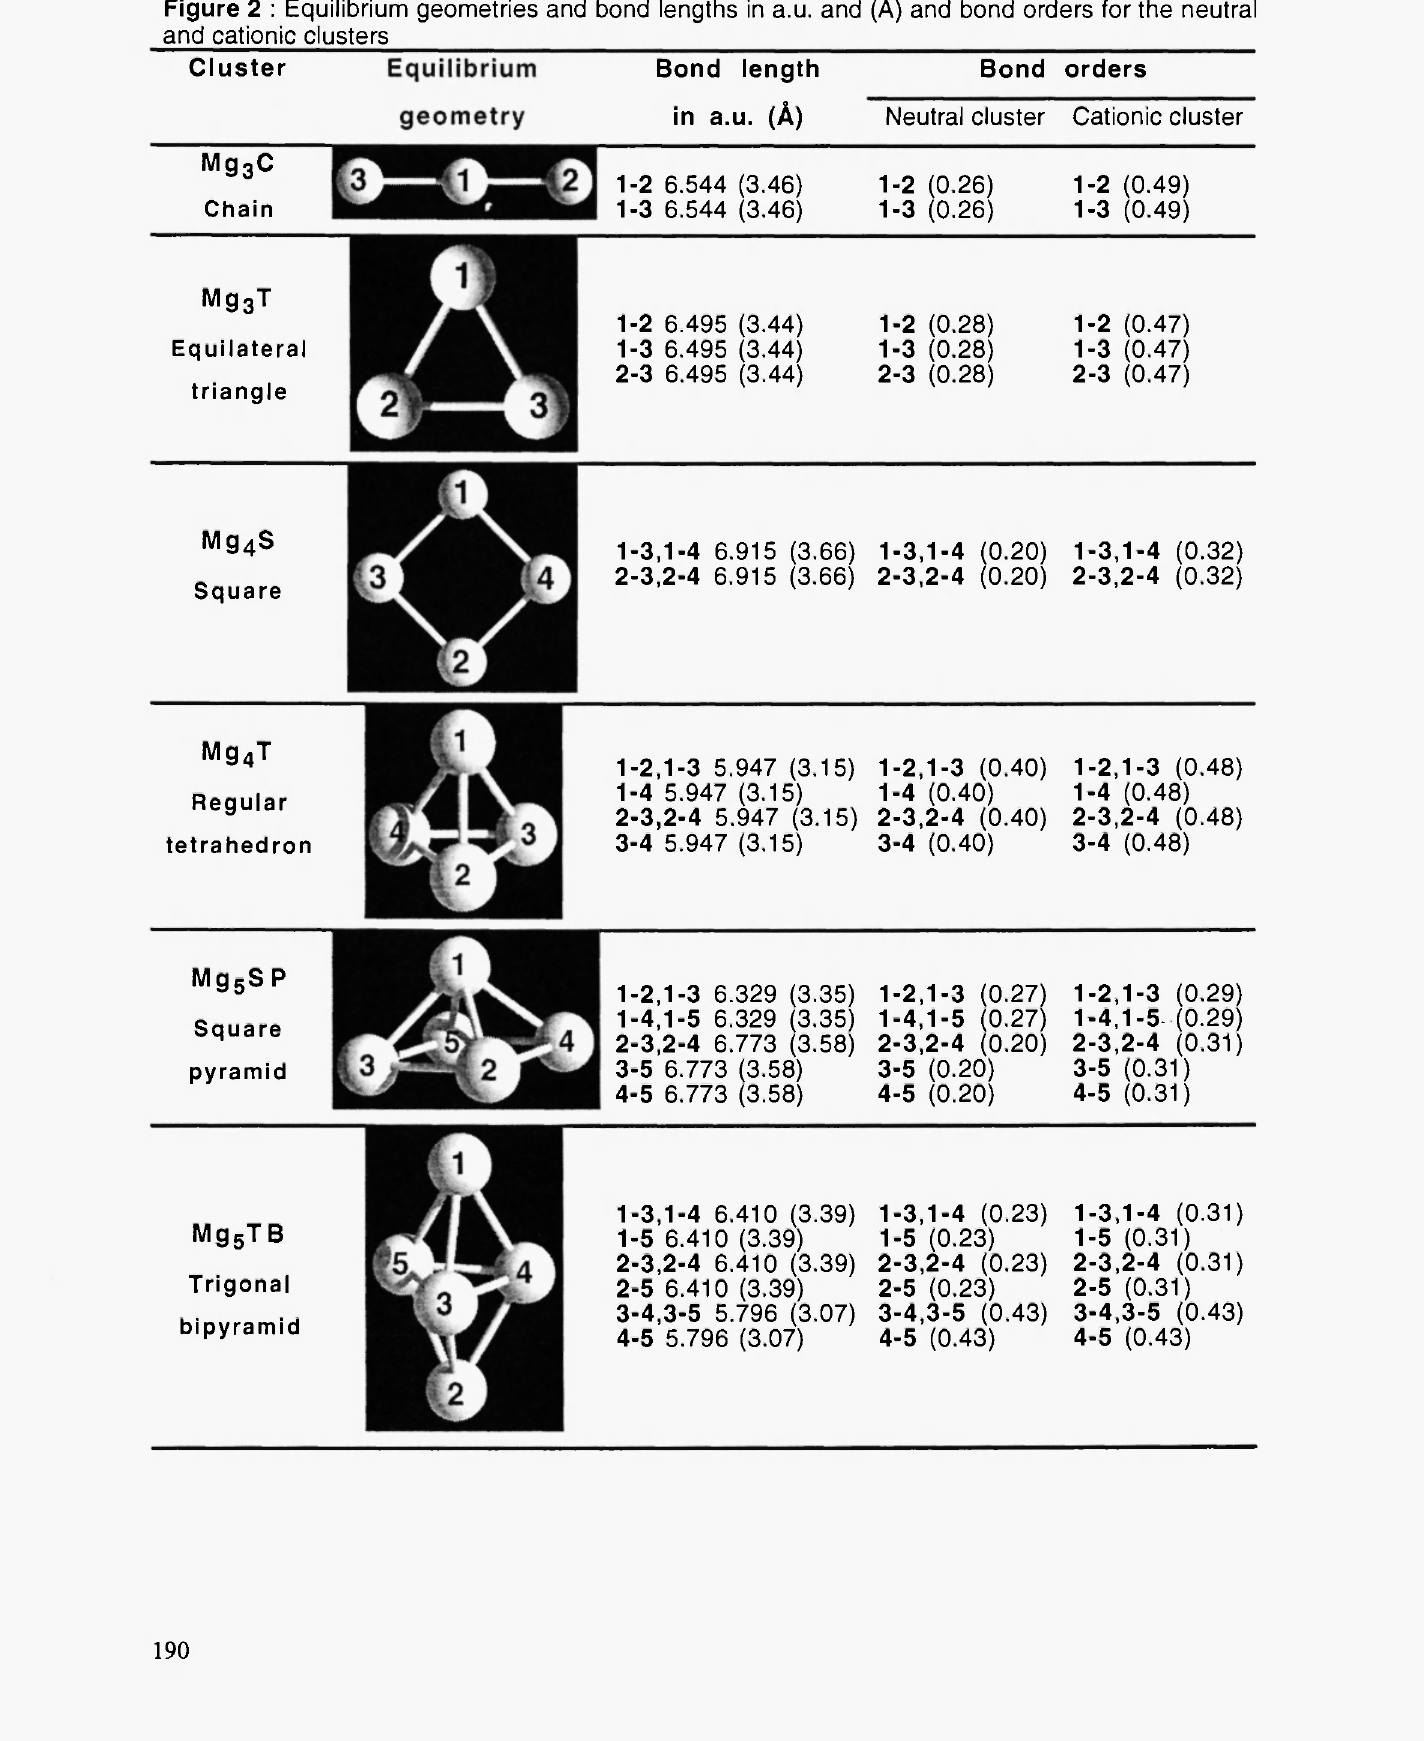
Figure 2 : Equilibrium geometries and bond lengths in a.u. and (Ä) and bond orders for the neutral and cationic clusters